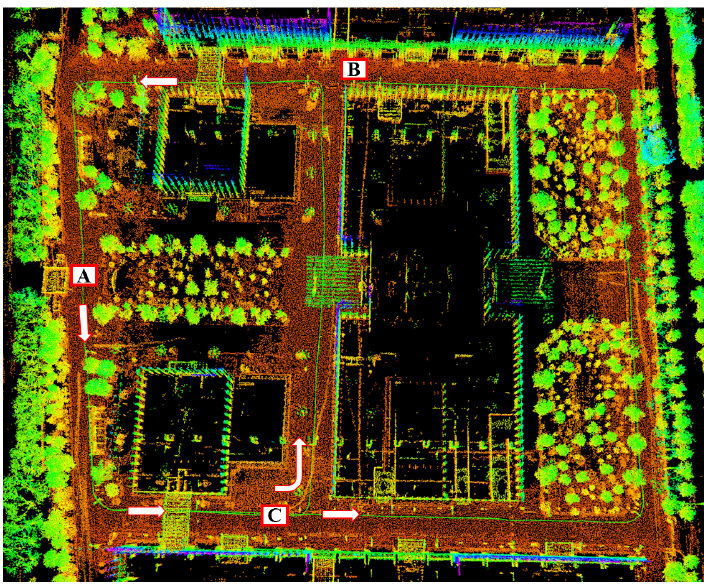
Figure 6. Mapping results on our own dataset using our proposed method. The capital letter A,B,C are used to indicate the road segment